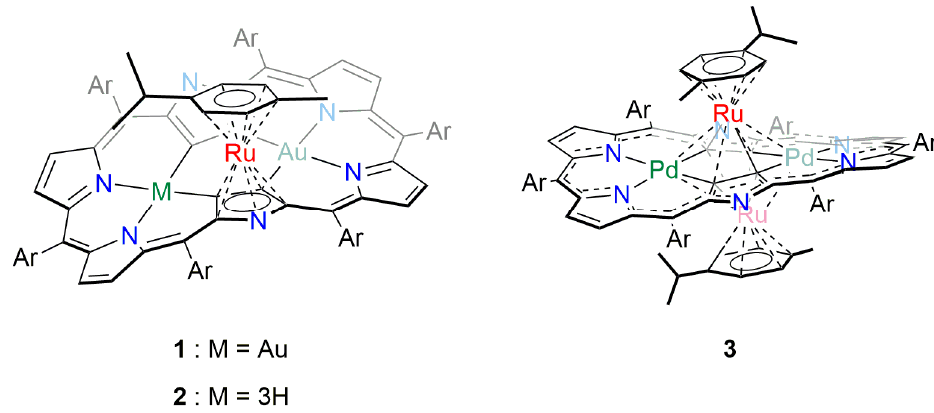
Figure 1. Schematic drawing of π -ruthenium complexes of hexaphyrins. Ar = pentafluorophenyl.